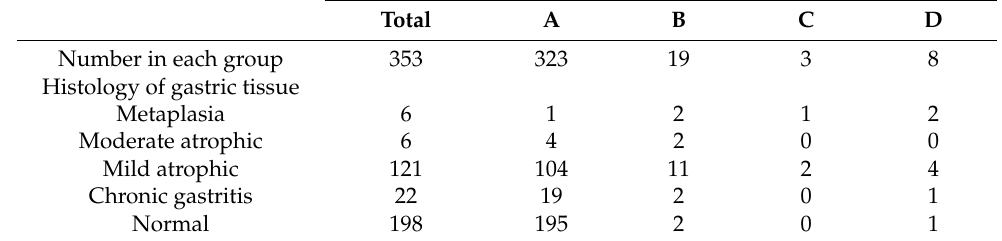
Table 6. Gastric mucosa status of each group using the ABC method with the Miki criteria versus the Sri Lanka-modified criteria.